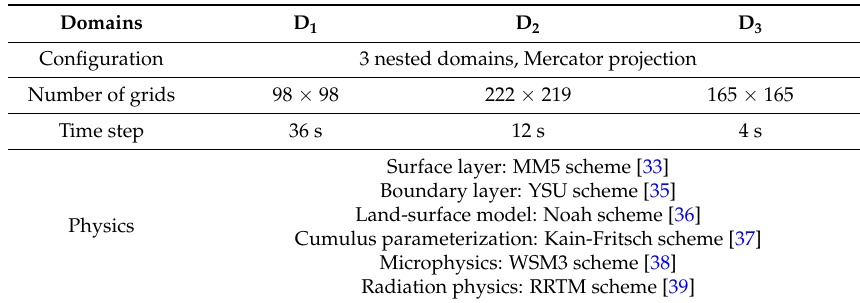
Table 2. Detailed settings of the WRF model. MM5: mesoscale model 5; YSU: Yonsei University; WSM3: WRF single-moment 3-class; RRTM: rapid radiative transfer